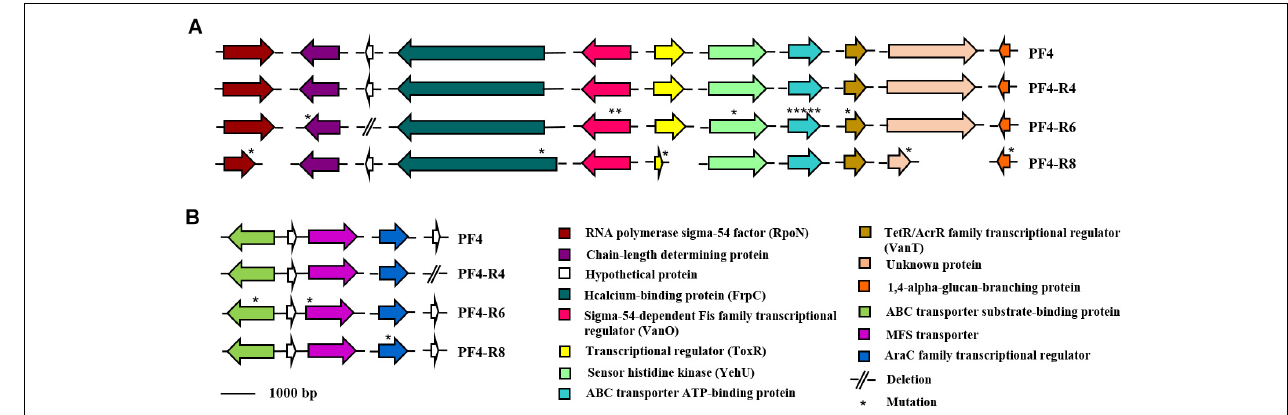
FIGURE 8 | Schematic representation of the distribution of specific mutations in phage-resistant strains of V. anguillarum . Genes are represented as arrows, point mutations are represented as asterisks and deletion mutations are represented by short lines. Functions for genes are shown in colored boxes. (A) Mutations in chromosome I (accession numbers NP_232157.1, WP_017048278.1, WP_017049544.1, WP_013856939.1, WP_010320686.1, WP_013857308.1, WP_010319157.1, NP_798862.1, WP_017043694.1 and WP_017046665.1, respectively) (B) Mutations in Chromosome II (accession numbers WP_017048771.1,